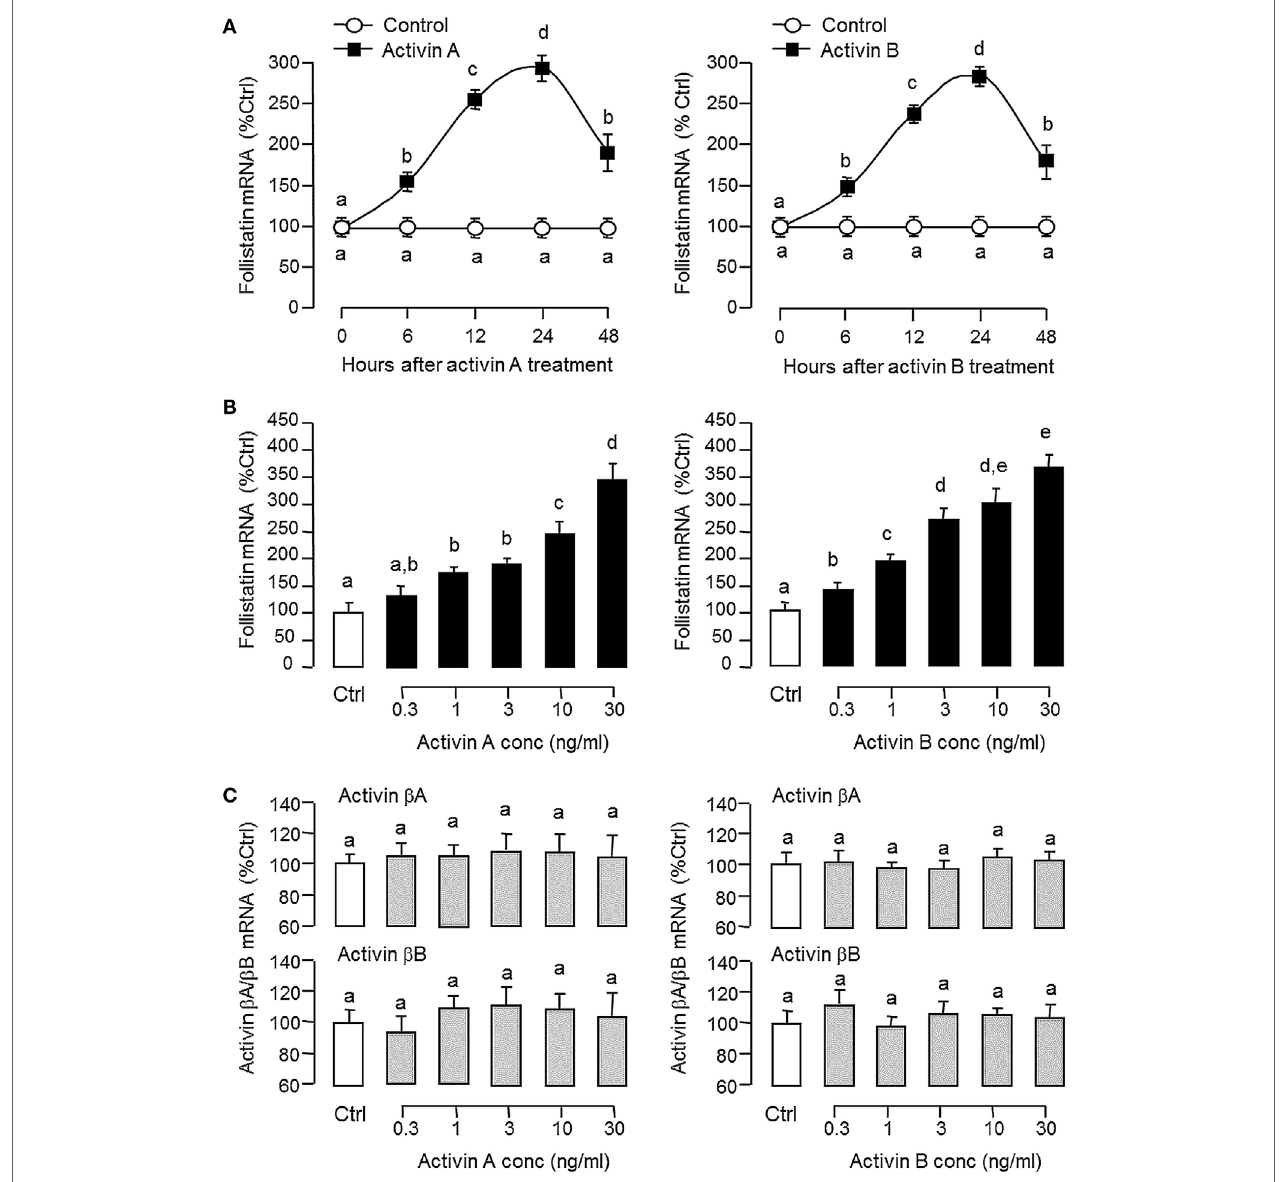
FigUre 3 | Effects of activin A and B on follistatin, activin β A, and activin β B expression in grass carp pituitary cells. (a) Time course and (B) dose dependence of activin-induced follistatin mRNA expression. (c) Dose dependence of activin treatment on activin β A and β B mRNA expression. In time course experiment, pituitary cells were incubated with activin A (10 ng/ml) or activin B (10 ng/ml) for the duration as indicated up to 48 h. To test for dose dependence, the duration of drug treatment was fixed at 24 h with pituitary cells challenged with increasing levels of activin A or B, respectively. After activin treatment, total RNA was isolated and used for real-time PCR of follistatin, activin β A, and activin β B mRNA, respectively. Data presented are pooled from four separate experiments ( N = 4) and the groups denoted by different letters represent a significant different at P < 0.05 (ANOVA followed by Newman–Keuls